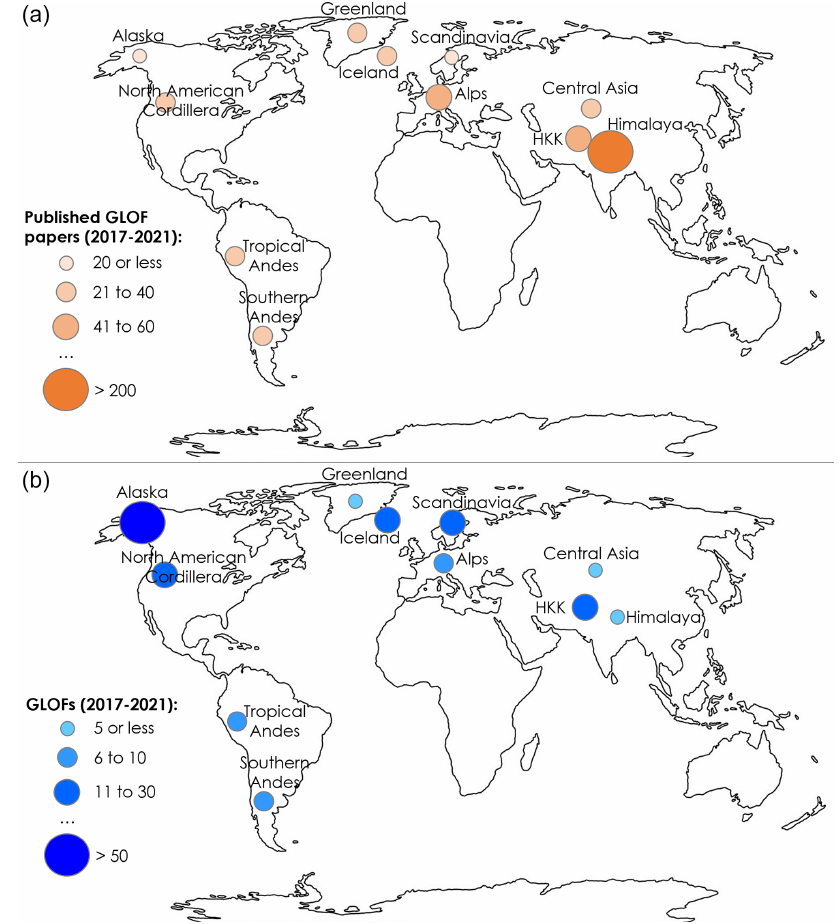
Figure 3. Geographical focus of published GLOF papers (a) and reported GLOFs which happened from 2017 to 2021 (b) (data from Veh et al., 2022, in May 2022; HKK denotes the Hindu Kush and